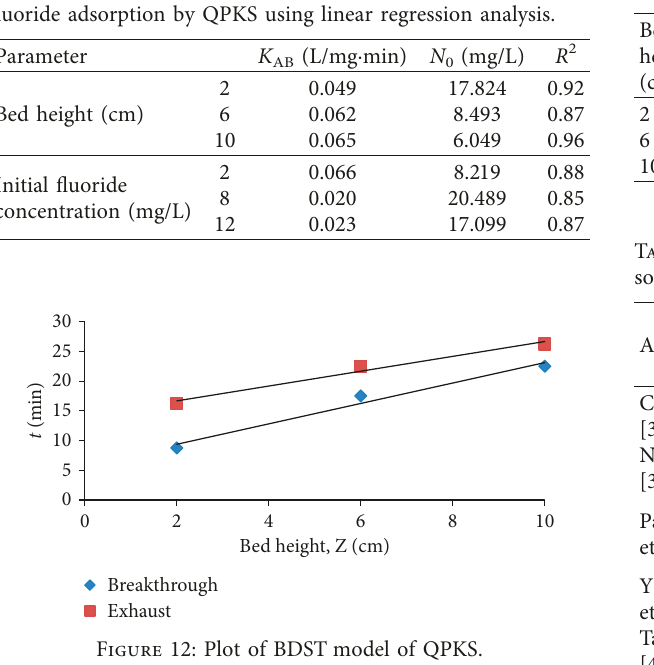
Table 9: BDST constant values for QPKS.